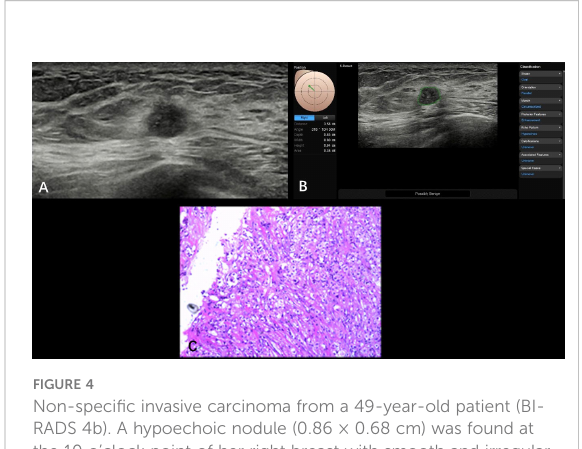
FIGURE 5 Intraductal papilloma from a 54-year-old patient (BI-RADS 4a). A hypoechoic nodule (1.12 × 0.65 cm) was detected at the 10 o ’ clock point of her right breast with smooth and irregular/ regular edges (S-Detect technology failed to draw the outline of this nodule), nonuniform distribution with some spotted hyper- echoes (A) . The S-Detect suggestion was “ possibly malignant ” and BI-RADS score declined from 4a to 4b (B) . Pathology result was intraductal papilloma shown in the picture (HE, ×100) (C) . Inaccurate boundary layer distributed inappropriate